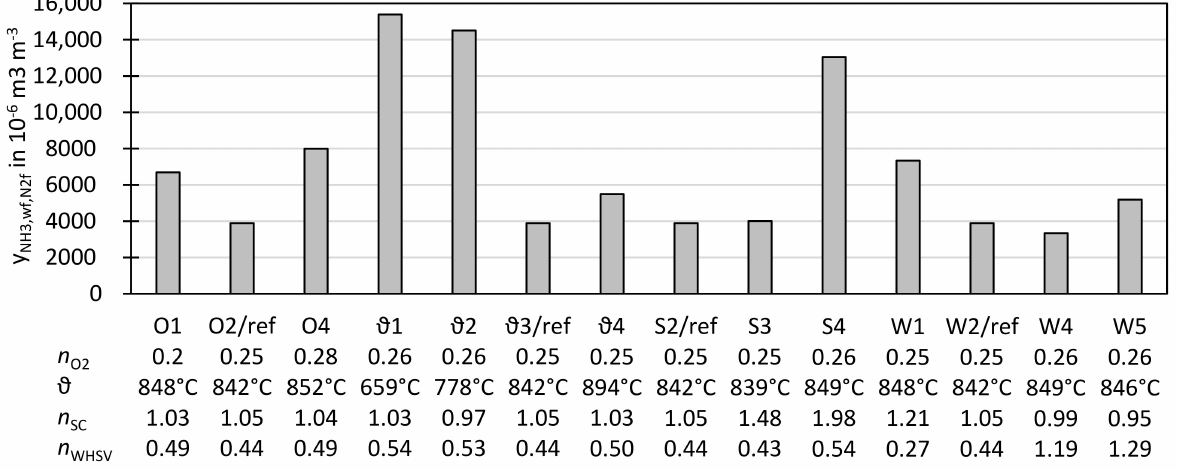
Figure 16. Compilation of all conducted NH 3